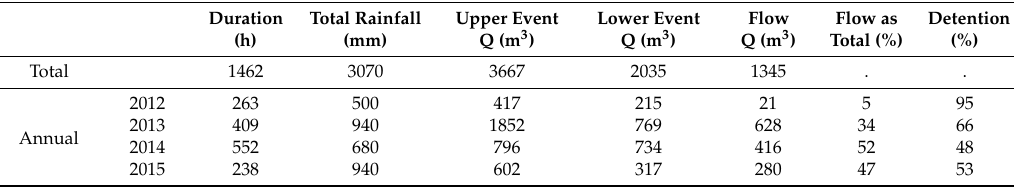
Table 2. Monitoring data tracked annual warm season precipitation events’ total duration and total rainfall and flows into (Upper Event Q), from upper to lower (Lower Event Q), and out (Flow Q) of the two-tier rain garden. Flow as total percent is percent of Upper Event Q that Flow Q represents. Detention is the percent of Upper Event Q that Flow Q does not